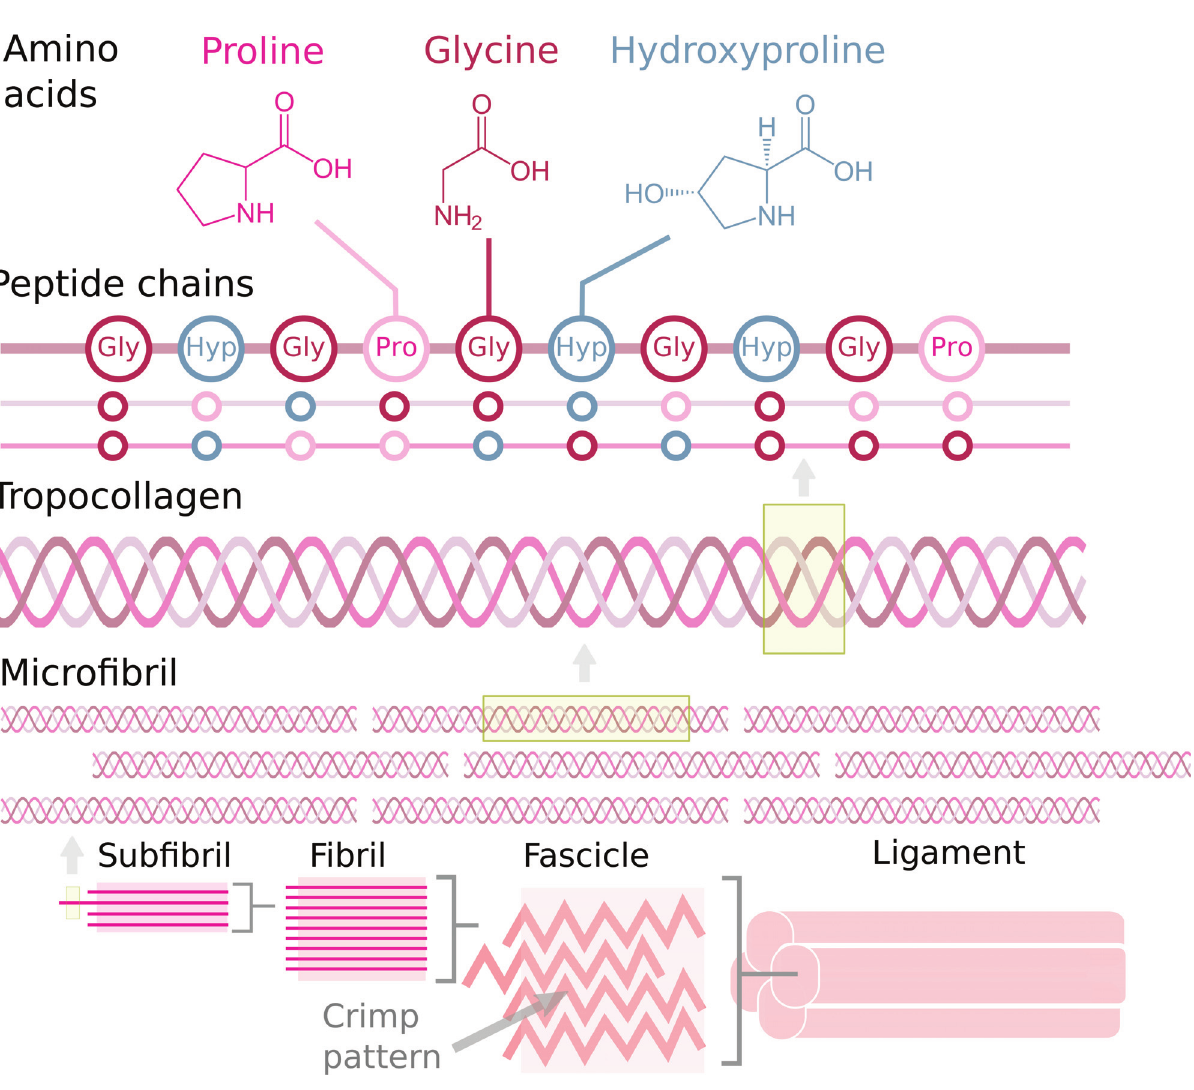
Fig 1. Ligament structure. The hierarchical structure of ligaments, and organization of the tropocollagen from triple-helical polypeptide chains.